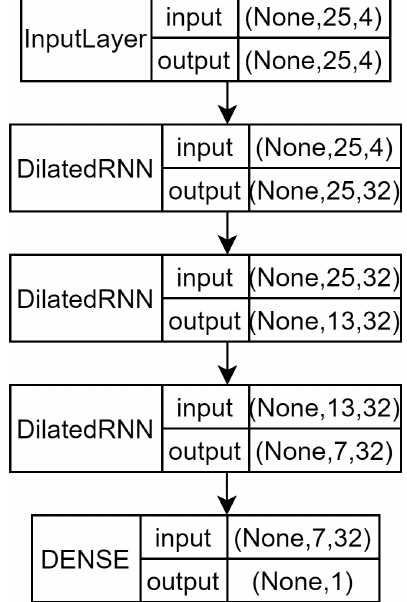
Figure A8. Zhu’s architecture block diagram. In [25], the last output is no longer a one-dimensional vector but a matrix with 100 highest output is considered the bin selected.